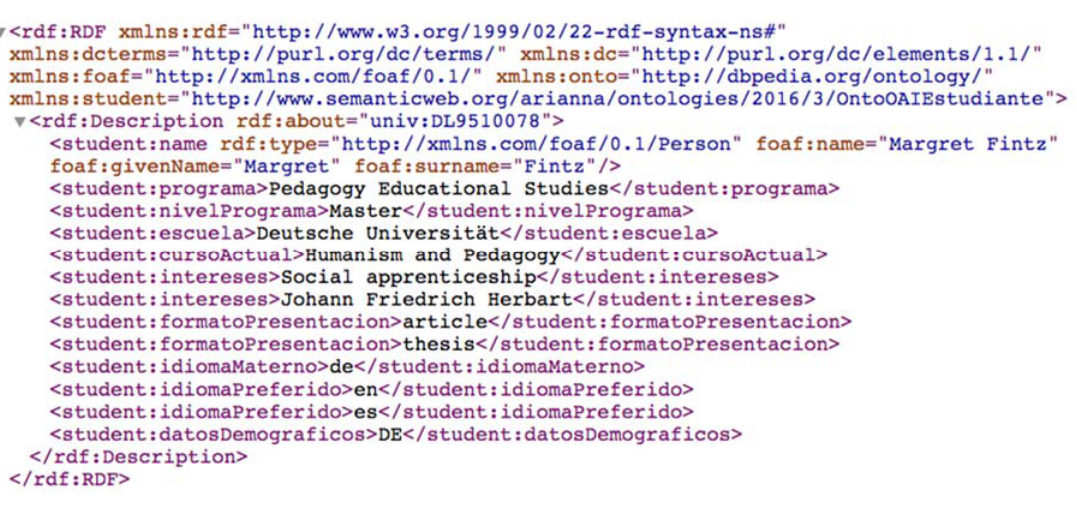
Figure 13. Profile of user univ: DL9510078.